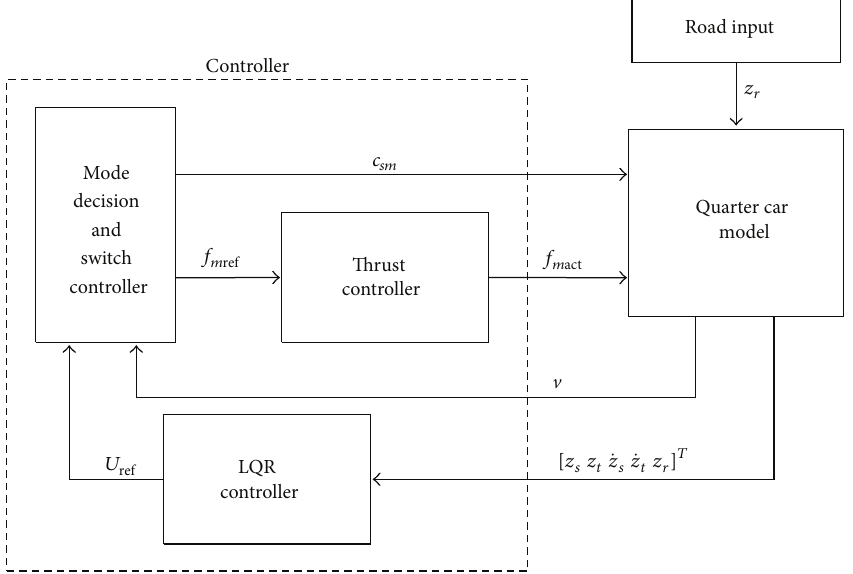
Figure 4: Block scheme of HASAS system.